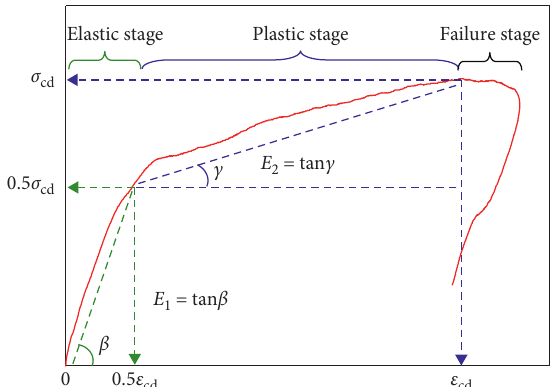
Figure 7: Defining method of elastic deformation modulus and plastic deformation modulus of jointed specimens.